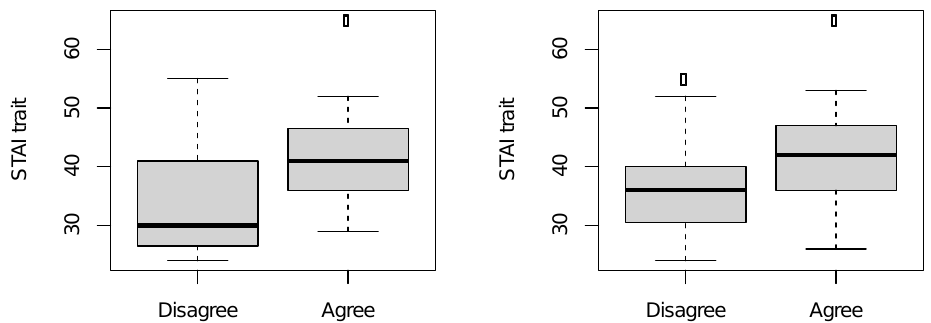
Figure 3. STAI trait in parents who reported a negative impact of the COVID-19 pandemic on becoming a parent due to less physical contact with the infant because of the preventive measures, and those who reported a negative impact of the COVID-19 pandemic on becoming a parent due to concerns about the infant ’s health.